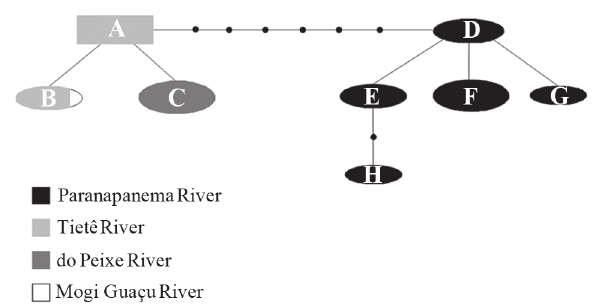
Fig. 4. Network of haplotypes generated by the TCS